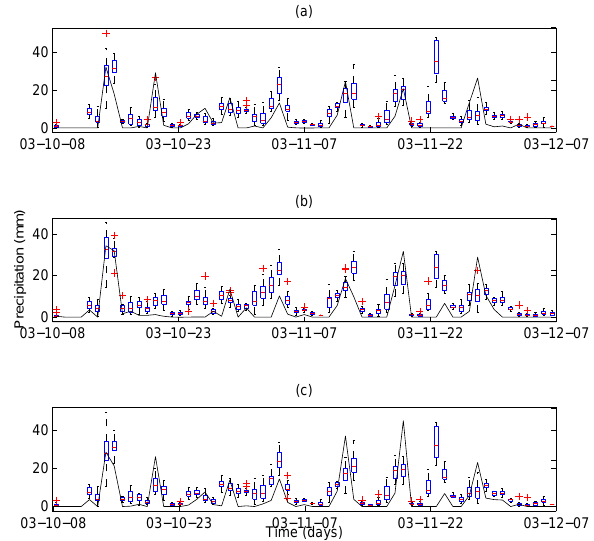
Fig. 3. Boxplots of 48h ahead ensemble precipitation forecasts compared to 48h ahead high resolution deterministic precipitation forecasts for (a) Station 7031360 (near outlet of the basin) (b) Sta- tion 7038885 (upper Baskatong, middle of the basin) and (c) Station 7038975